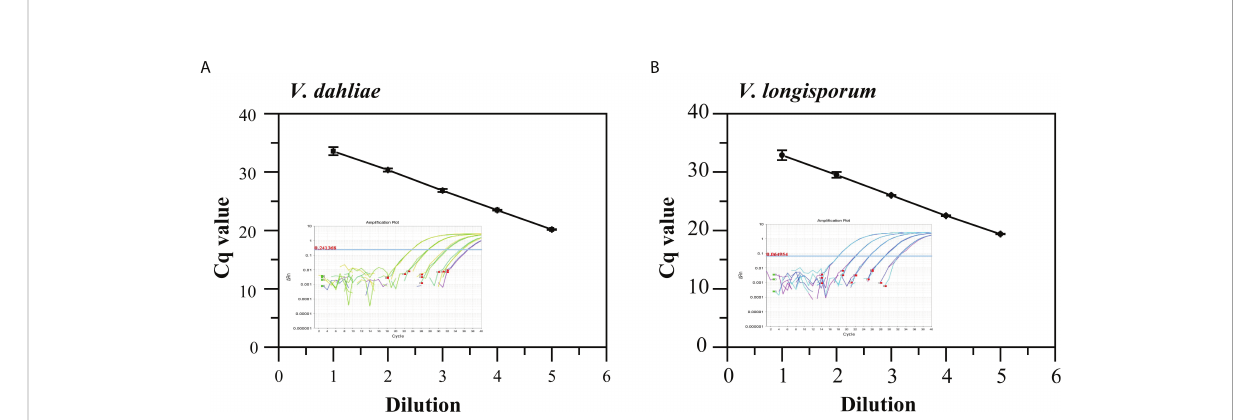
FIGURE 2 Standard curves and ampli fi cation curves of qPCR assays targeting IGS to detect V. dahliae (A) and V. longisporum (B) . Means of three independent measurements are shown; each error bar represents the standard deviation of the Cq